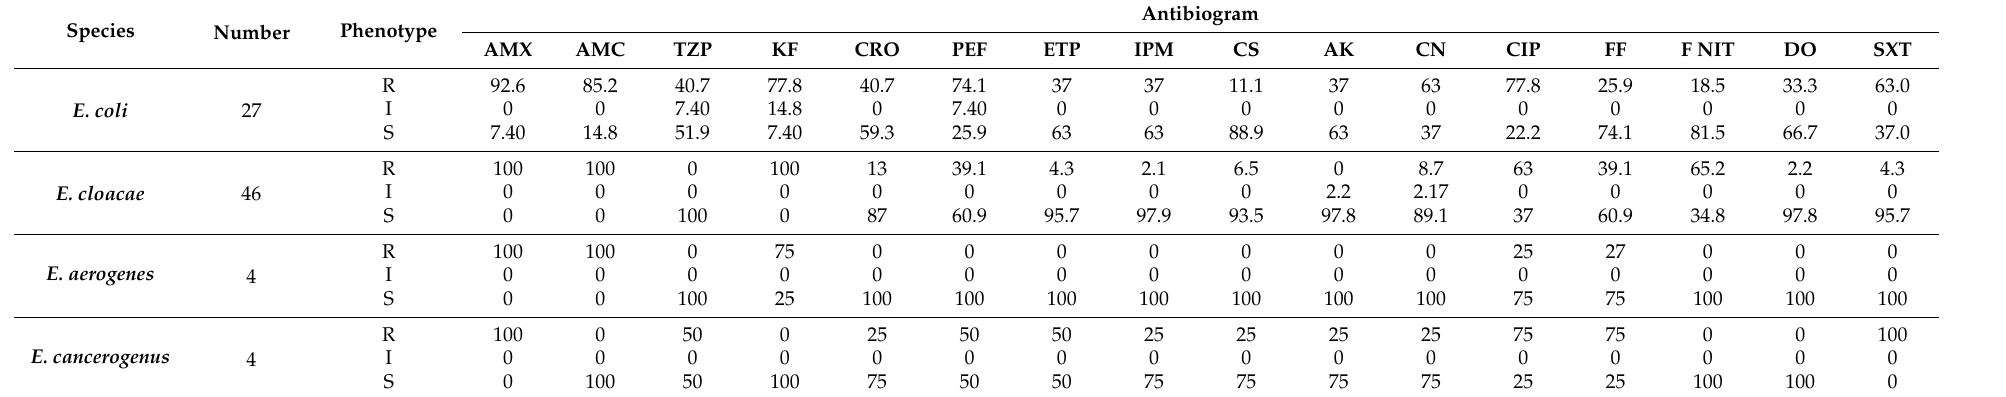
Table 2. Susceptibility of fermentative GNB against tested antibiotics.